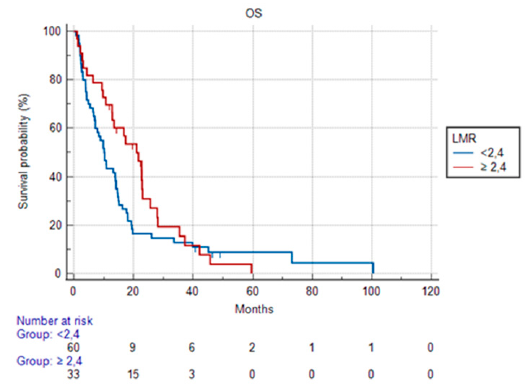
Figure 3. Overall survival according to LMR.